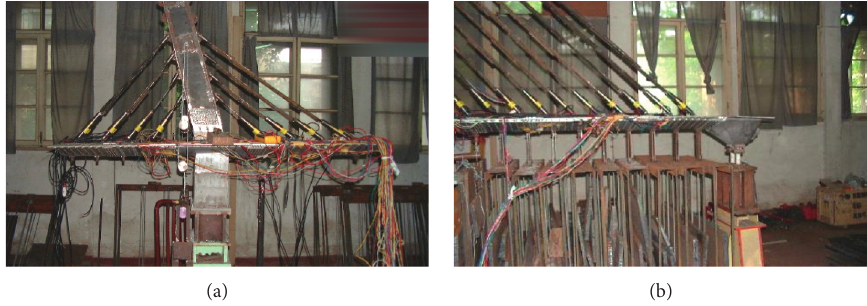
Figure 3: Installing the model. (a) Installing four pairs of stay cables at pier #4. (b) Closure of side span of pier #5.